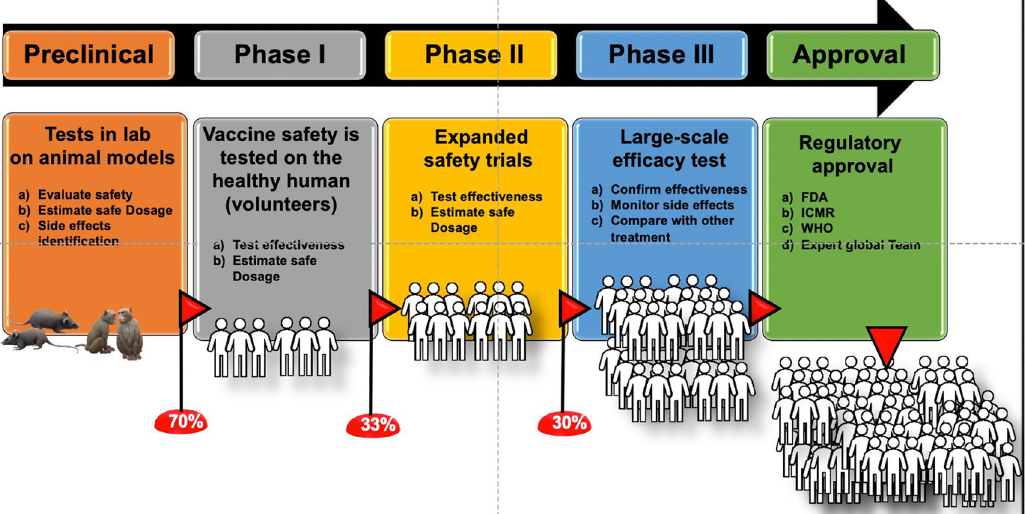
Figure 1: Stages of vaccine development. Vaccines requires largely five major steps, starting with preclinical tests in animal models, phase I involves limited number of human individuals and each of the next steps needs exponible increments of human individuals and it decreases change of success to reach to next levels and only limited numbers of vaccines are approved for public use by regulatory agencies of different